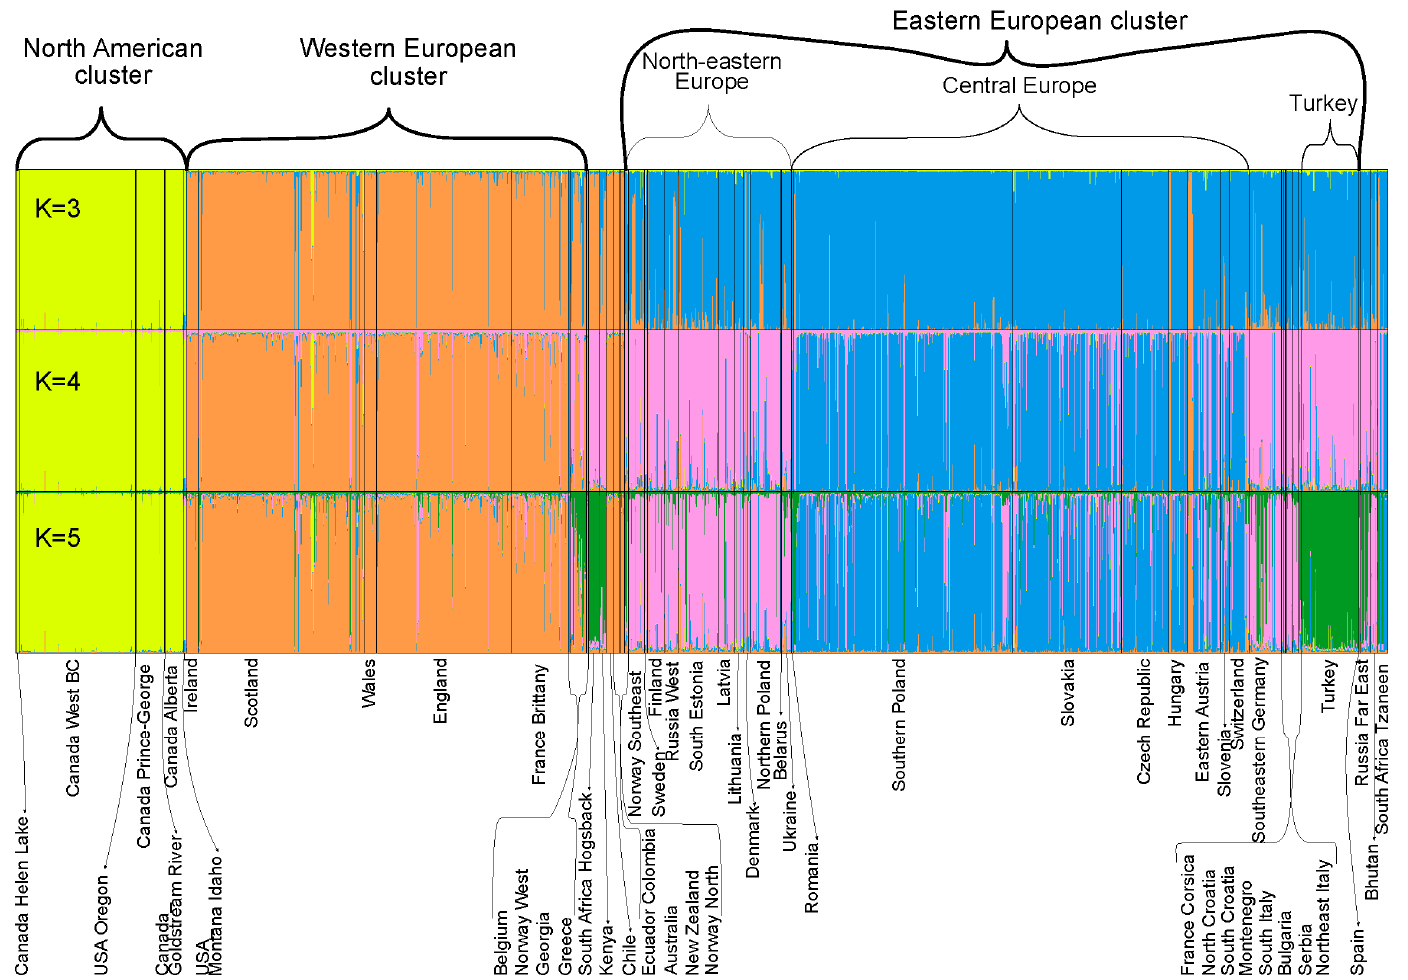
Figure 2. Bayesian clustering of D. septosporum multilocus haplotypes inferred using the program STRUCTURE at K = 3, K = 4 and K = 5. Each multilocus haplotype is represented by a vertical line partitioned into colored sections that represent the isolate’s estimated membership fractions in each cluster. Black lines separate isolates from different population